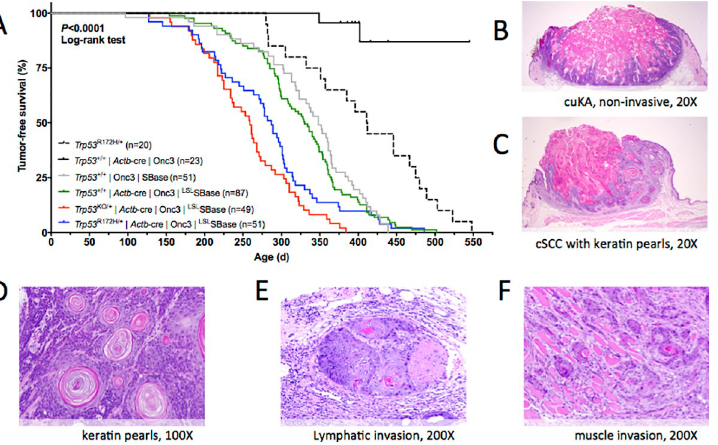
Fig 1. Whole-body SB transposon mutagenesis drives a diverse tumor spectrum in Trp53 wild type and mutant mice. ( A ) Kaplan-Meier survival curves comparing experimental SB and non-SB control mouse cohorts (log-rank test, P < 0.0001). Wild type Trp53 cohorts with SB-Onc3 mobilized by a constitutively active Rosa26 -SBase allele (Gray line, reported in [7]) do not differ significantly from SB-Onc3 mice mobilized by a conditionally activated Rosa26 - LSL-SBase allele to the Rosa26 -1lox-SBase allele by whole body Cre expression (log-rank test, P > 0.05). Mice in all SB-Onc3 cohorts developed solid tumors, including cutaneous squamous cell carcinoma (cuSCC) and hepatocellular adenoma (HCA), but Trp53 +/ − (red line) and Trp53 R172H/+ (blue line) mice had significantly decreased survival compared to the wild-type (WT) cohort (Green line, P < 0.0001, log-rank). Non-SB control Trp53 R172H/+ mice (dashed black line) had significantly decreased survival compared to the WT cohort (solid black line, P < 0.0001, log-rank). ( B-C ) Histology and tumor classification from sections of skin masses stained with hematoxylin and eosin. ( B ) Early- stage, non-invasive mass with cutaneous keratoacanthoma-like morphology (cuKA) in SB-Onc3| Trp53 +/+ mouse (20 × ). ( C ) Invasive mass with cuSCC displaying keratin pearl morphology in SB-Onc3| Trp53 KO/+ mouse (20 × ). ( D ) cuSCC keratin pearls in SB-Onc3| Trp53 +/+ mouse (100 × ). ( E ) cuSCC displaying lymphatic invasion in SB-Onc3| Trp53 R172H/+ mouse (200 × ). ( F ) cuSCC displaying muscle invasion in SB-Onc3| Trp53 +/+ mouse (200 × ). 60 histologically confirmed cuSCCs, 11 cuKA and 32 normal skin genomes (S2 Table ) using an enhanced version of SB Capture Sequencing (SBCapSeq) from our previously published workflow [9] that is optimized for liquid-phase capture of transposons from both normal and